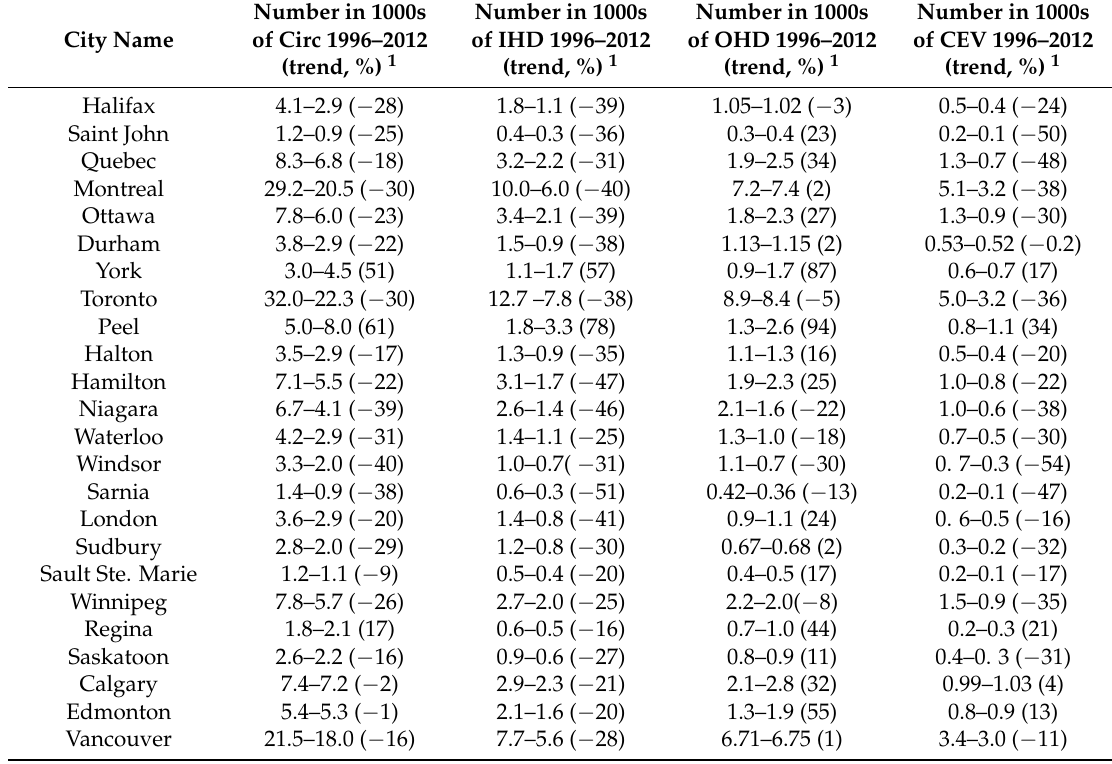
Table 2. Statistics on circulatory hospitalization for 24 Census